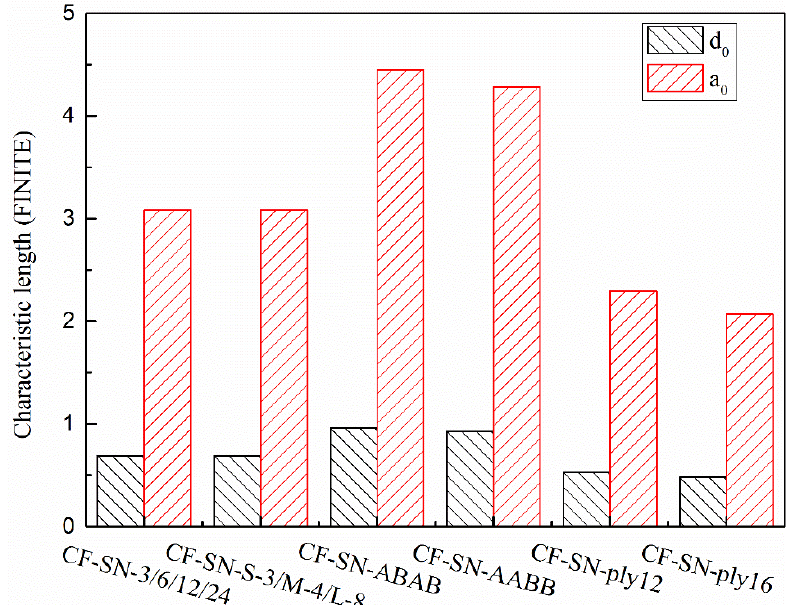
Figure 21. Average characteristic lengths, d 0 and a 0 , of each type of specimen (equal specimen size group/equal ratio of W /2 C group/CF-SN-ABAB/CF-SN-AABB/CF-SN-ply12/CF-SN-ply16) calculated by the finite-width stress model; both the lay-up sequence and layer number affect the characteristic length.